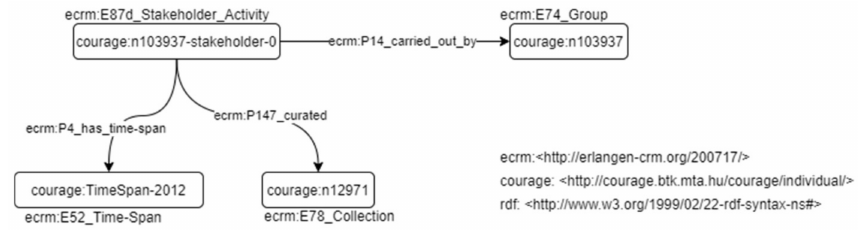
Figure 8. Stakeholder role representation in CIDOC-CRM.